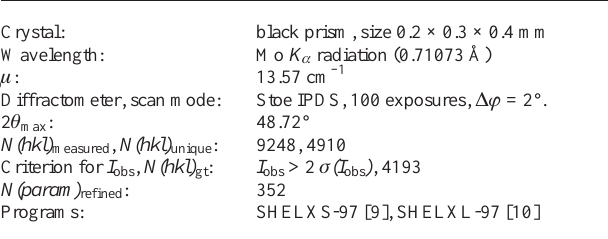
Table 1. Data collection and handling.